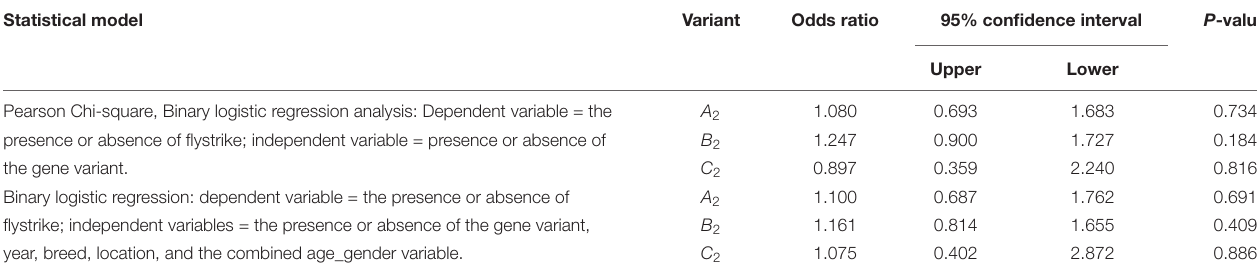
TABLE 4 | The association of the presence of each FABP4 Region-2 variant with the occurrence of flystrike given the presence of a particular FABP4 Region-2 variant. Statistical